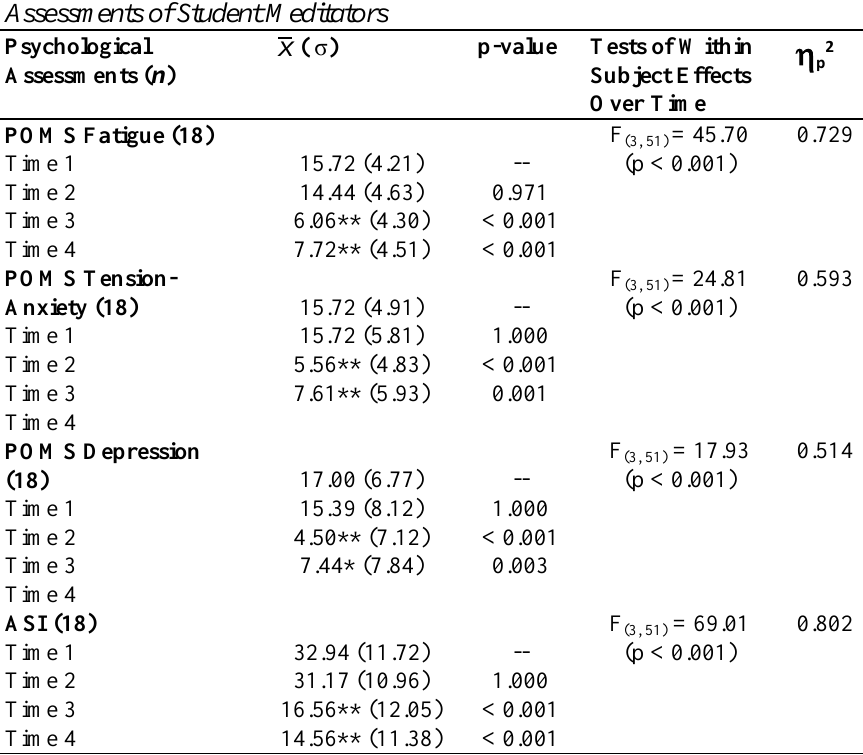
Table 3: One Way Repeated Measures ANOVA Results for Psychological